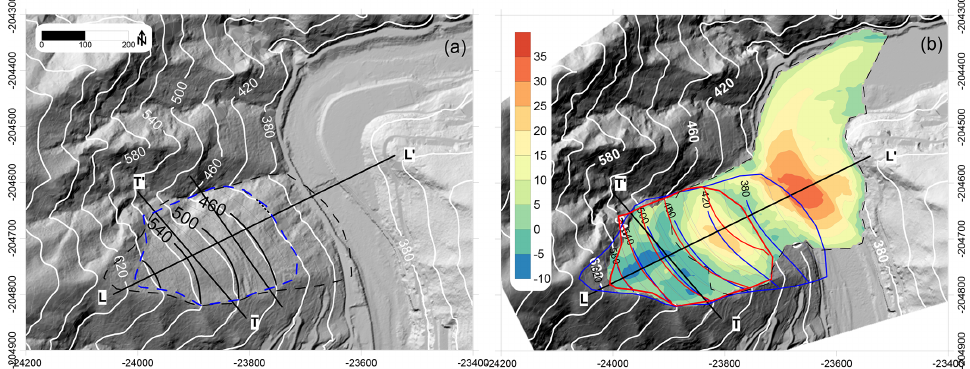
Figure 11. (a) A reconstruction of the topography of the Shimizu landslide based on the 5m post-DEM (in black) compared to that DEM. (b) Comparison of the SLBL scenarios with the post-DEM and the results of the deposit thickness (colour scale) determined using the difference between the mixed scenario (in red) and 5m post-DEM; scenario 1 is shown in blue. The dashed line indicates the contour used to define the volume.